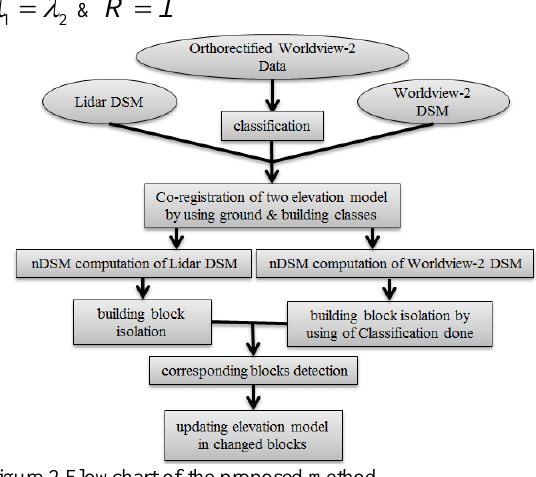
Figure 1.From top to bottom, LIDAR DSM, RGB image created from bands 2, 3 & 5 and Stereo-based DSM from Worldview-2.